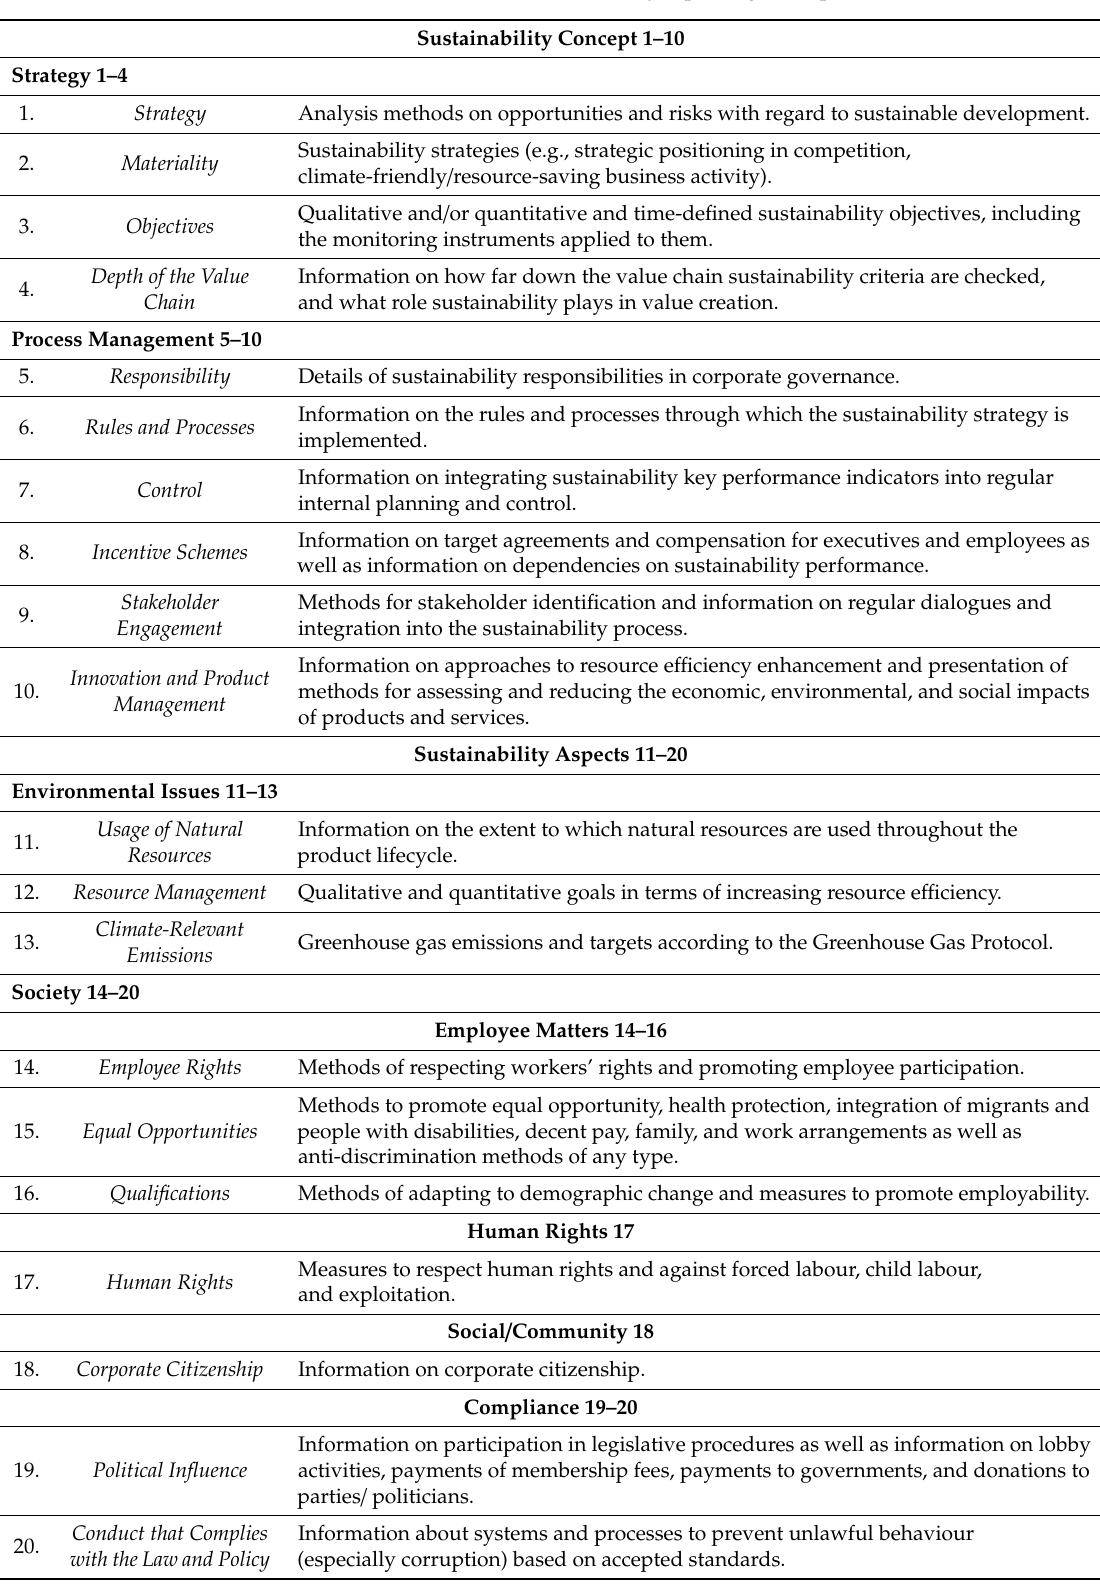
Table 1. Overview of DNK sustainability reporting